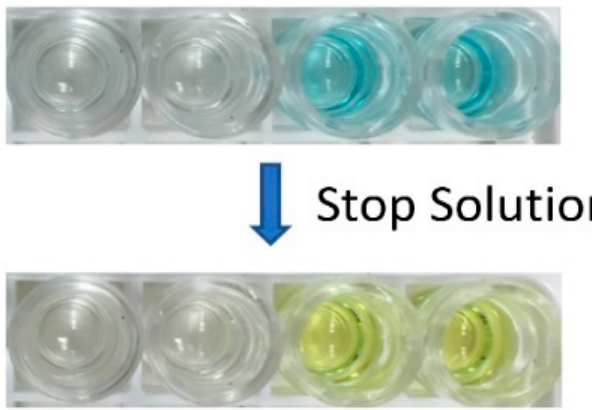
Figure 6. Colorimetric bioassay results after the stop solution is added. The wells with the blue solution are the positive controls and the colorless wells represent the negative controls.